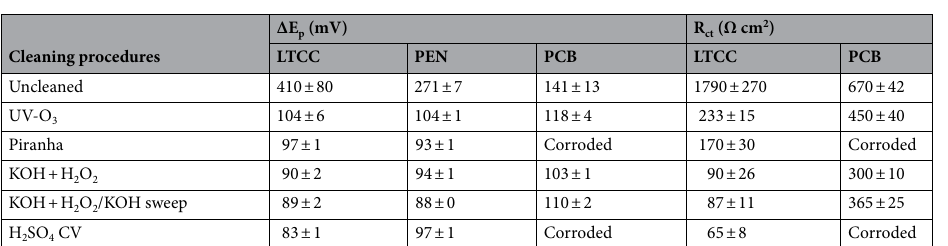
Table 1. Peak potential difference (∆E p ) and charge transfer resistance (R ct ) values for different Au sensors before and after cleaning procedures. The R ct values were normalized by the effective electrode area. Measurements are averaged over four separate